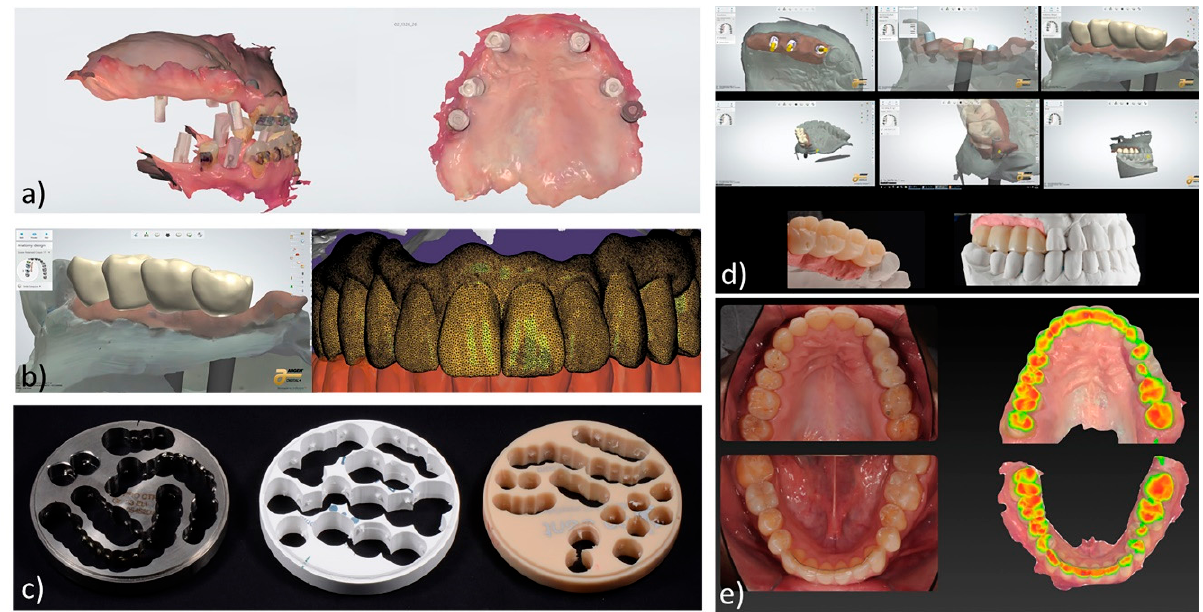
Figure 1. Clinical steps in CAD/CAM provisional restorations and their clinical wear analysis: ( a ) oral scanning of 3D implants position and surrounding tissues; ( b ) CAD—design of dental prosthesis; ( c ) CAM blanks: alloys (left), presintered zirconia (center), polymer (right); ( d ) CAD—design and machined final product of stone-cast oral replicas; ( e ) wear analysis after clinical use.